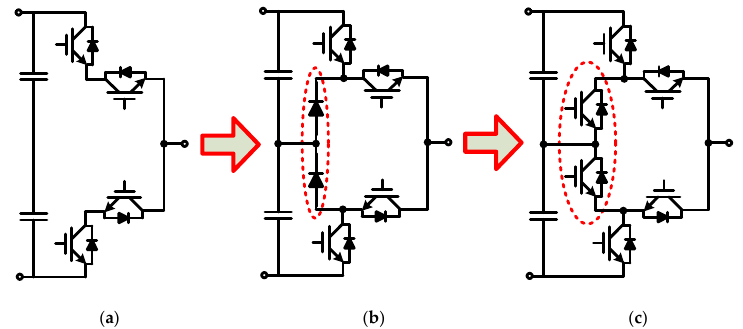
Figure 3. Derivation process of 3L ANPC converter. ( a ) 2L cell [28], ( b ) 3L NPC converter [5], ( c ) 3L ANPC converter [13]. ANPC converter [13].